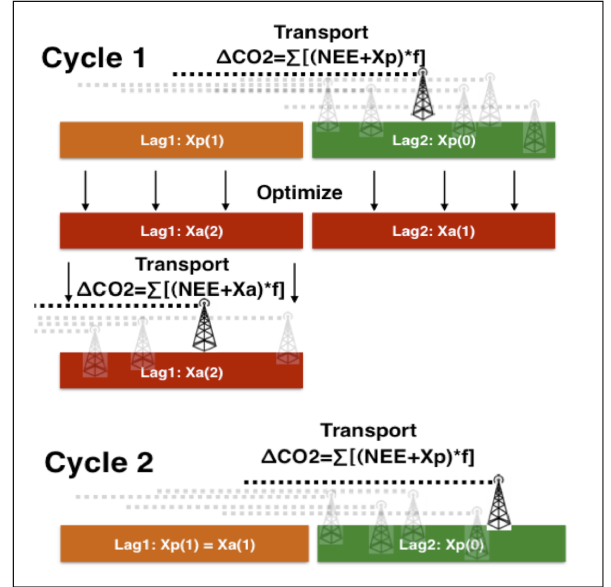
Figure 2. The time stepping flow of the ensemble Kalman smoother filter used in CTDAS-Lagrange. The Xp (n) and Xa (n) represent the prior and optimized state vector of a 20-day period shown as two colored bars from left to right. Parameter n denotes the number of times the state vector has been updated. Each of the colored bars represents a “lag” of 10 days. In the transport step we calculate the CO 2 mole fraction variations ( (cid:49) CO 2 ) for each measurement (shown as a tower) by convolving the net biosphere flux NEE + Xp / Xa with footprints f (shown as a dashed line). Cycle 1 starts by introducing a new set of observations and fluxes at the front of the filter in lag 2. This part of the state vector has not been optimized before (green color, n = 0). At the rear end of the filter, in lag 1, the state vector has been optimized once in the previous cycle (orange color, n = 1). To estimate (cid:49) CO 2 for each observation requires con- volving footprints with 10-day 3-hourly NEE + Xp. Optimization is done on all 20 days (2 lags of the filter) to find the optimal values in the entire state vector. The state vector of lag 1 is done and will not change again (red color, n = 2). This new optimized state vector Xa(2) is used to calculate the final (cid:49) CO 2 in lag 1 (final transport step ). Cycle 2 starts by introducing a new set of observations and fluxes at the front of the filter in lag 2. The analyzed state vector Xa(1) in lag 2 of Cycle 1 becomes the new prior state vector Xp(1) in lag 1 of Cycle